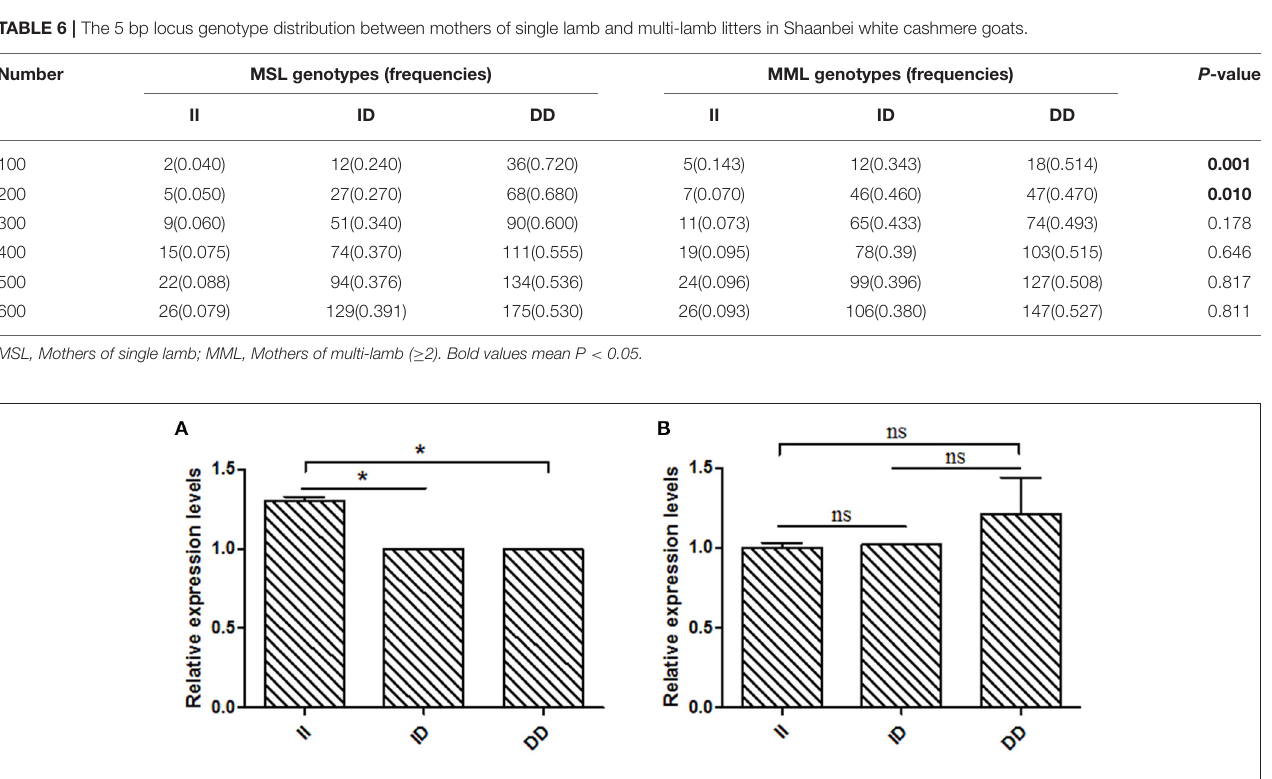
FIGURE 6 | The 16 bp indel locus influence KDM6A expression in meiosis period. (A) In the 16 bp locus, genotype II had a significantly higher KDM6A expression level than genotype ID and DD. (B) In the 5 bp locus, there was non-difference among different genotypes. Data represent means ± SE. * P < 0.05; ns, no significance.